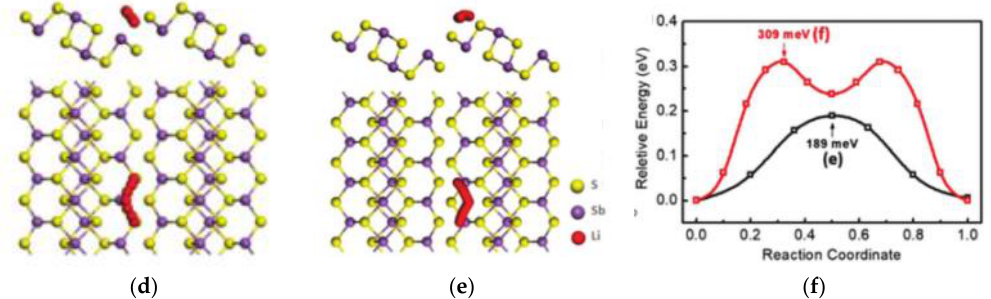
Figure 3. ( a ) Results of LPSs (5 mM Li 2 S 6 -DOL/DME solution) adsorption experiments with Carbon nanotubes (CNTs) and CoP and CoP-R nanoparticles supported on CNTs [31]. ( b ) Cycling performance of a high-capacity S cathode (S mass loading: 7 mg cm −2 ; rate: 0.2 C) modified with CoP-CNT [31]. ( c ) A comparison of the bond energies between the metal oxides and polysulfides (light green) with the specific capacity of the corresponding Li−S cells after 100 cycles at 1 C (green). These cells were made using RSL containing these metal oxides, respectively. The bond energies were calculated with Flore’s equation based on dissociation energy, electronegativity, and chemical hardness of metal oxides and polysulfides [32]. ( d , e ) Schematics of top and side views representing two Li diffusion pathways on Sb 2 S 3 nanosheets and ( f ) the corresponding energy profiles for different diffusion pathways [33].